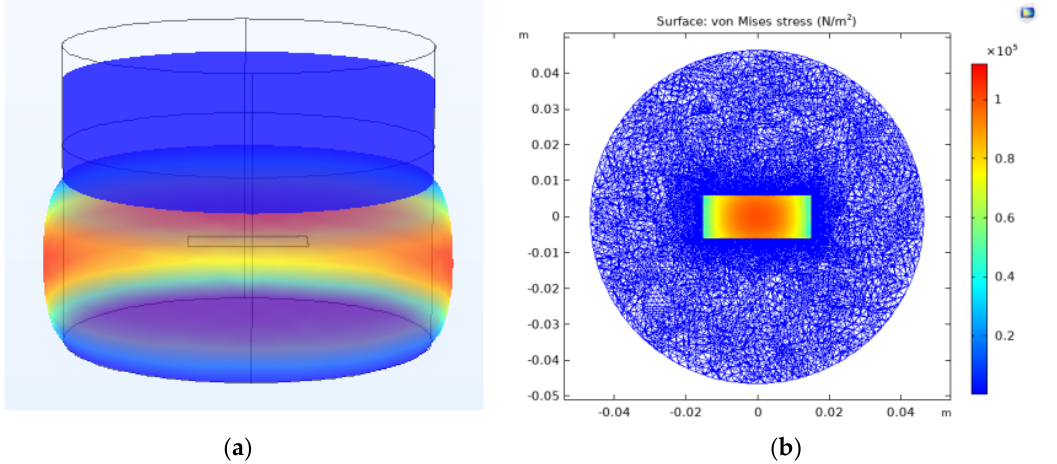
Table 2. Averaged volume averaged stresses applied on PVDF elements at 87 Hz.